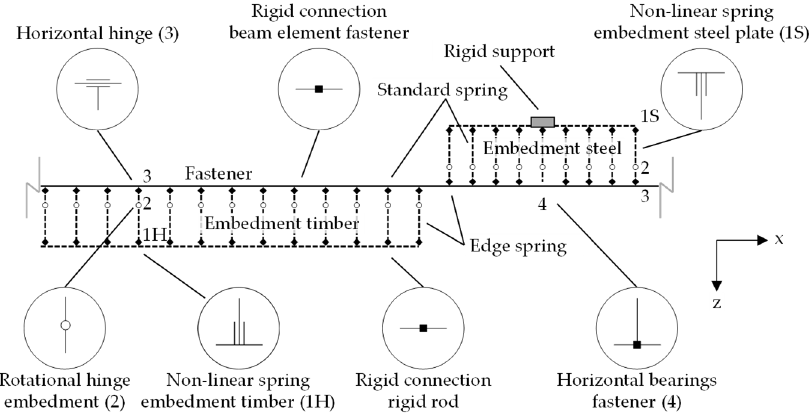
Figure 11. Details of the numerical Beam-on-Foundation (BoF) model and overview of the individual elements [29].